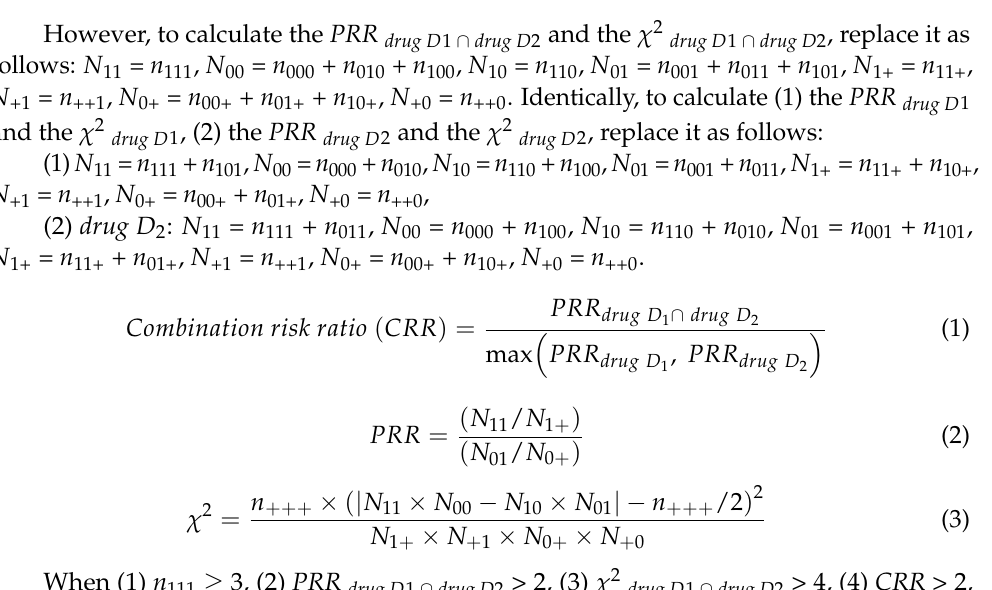
Table 1. The 4 × 2 contingency table for signal detection: AE: adverse event; n : the number of reports. Target AE Other AEs Total Concomitant use of drug D 1 and drug D 2 n 111 n 110 n 11+ only drug D 1 n 101 n 100 n 10+ only drug D 2 n 011 n 010 n 01+ Neither drug D 1 or drug D 2 n 001 n 000 n 00+ Total n ++1 n ++0 n +++